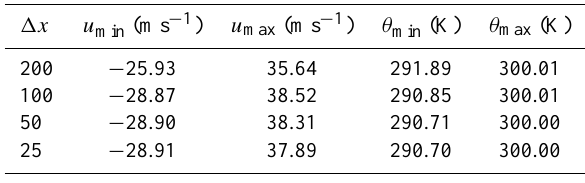
Table 4. Convergence study for the density current test case with a 1km tall hill. Minimum/maximum values of horizontal velocity and potential temperature for different grid spacings.